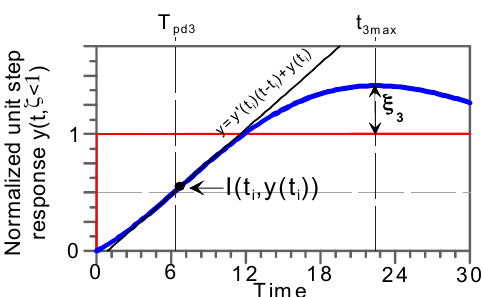
Figure 15: Unit step response of the second order active system for 2 07 25.2,104,3.0 ωαπωζ === and nn